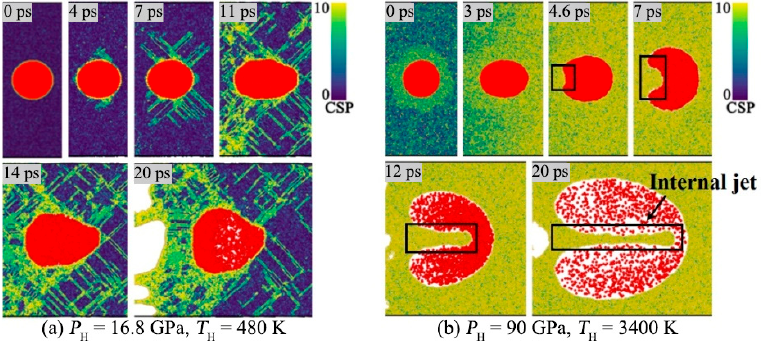
Figure 11. The local microstructure evolution of the He bubble under the case of L = 45 a for ( a ) P H = 16.8 GPa and ( b ) 90 GPa. The matrix atoms are color-coded by CSP.